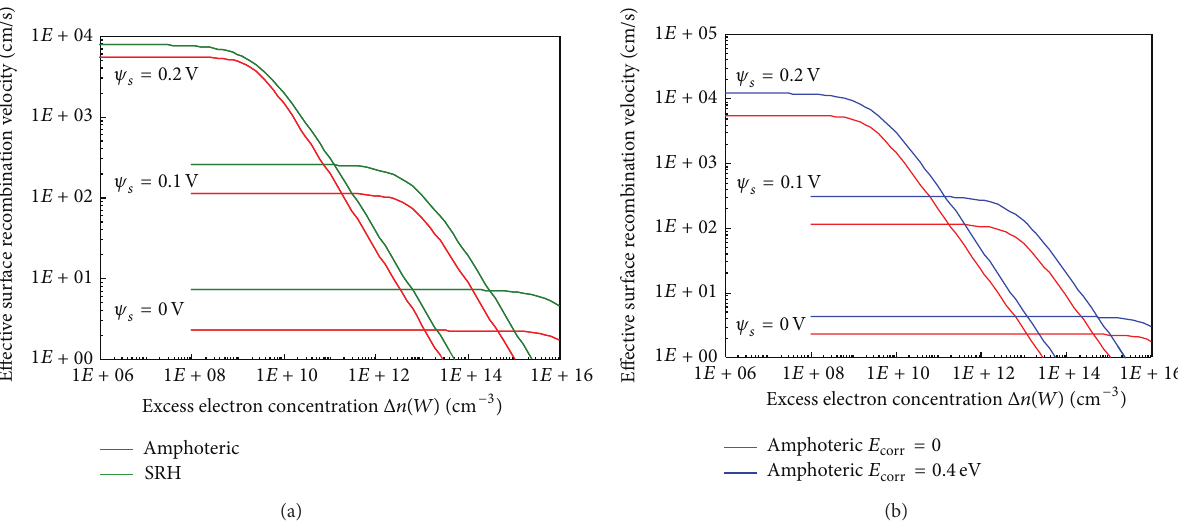
Figure 2: (a) SRH and amphoteric center surface recombination velocity 𝑆 assuming all capture cross-sections are equal, 𝐸 𝑆 as a function of excess electron concentration Δ𝑛(𝑊) assuming all capture cross-sections are equal for 𝐸 amph 0.1V and 0.2V.